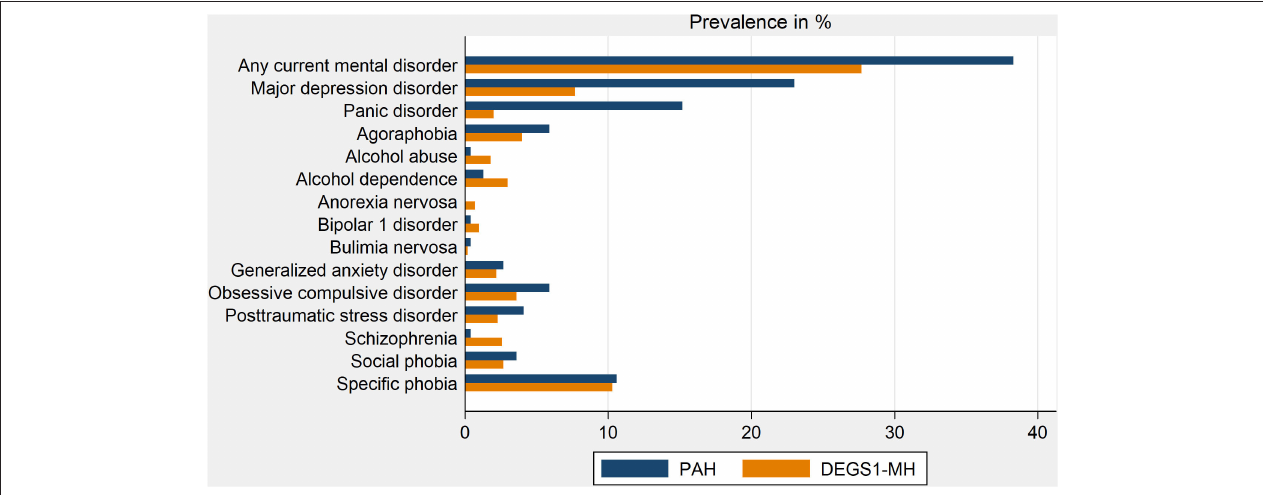
decline in the overall QoL, and a decline in 6MWD by 10 m was accompanied by a 0.3-point decline in QoL. The